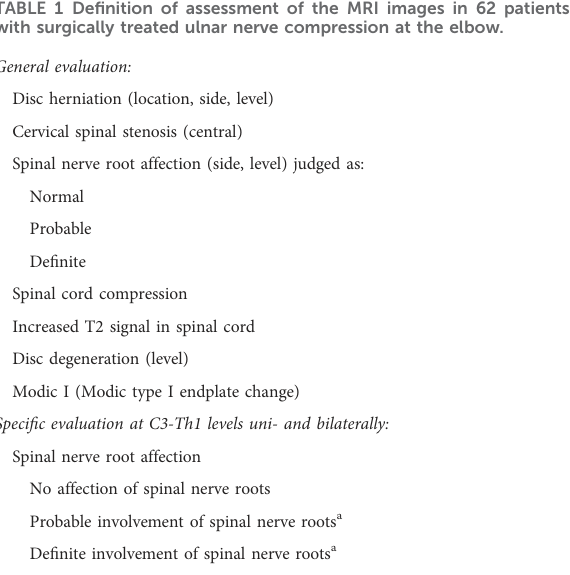
TABLE 2 Characteristics of patients with surgically treated ulnar nerve compression at the elbow and with available MRI of neck.